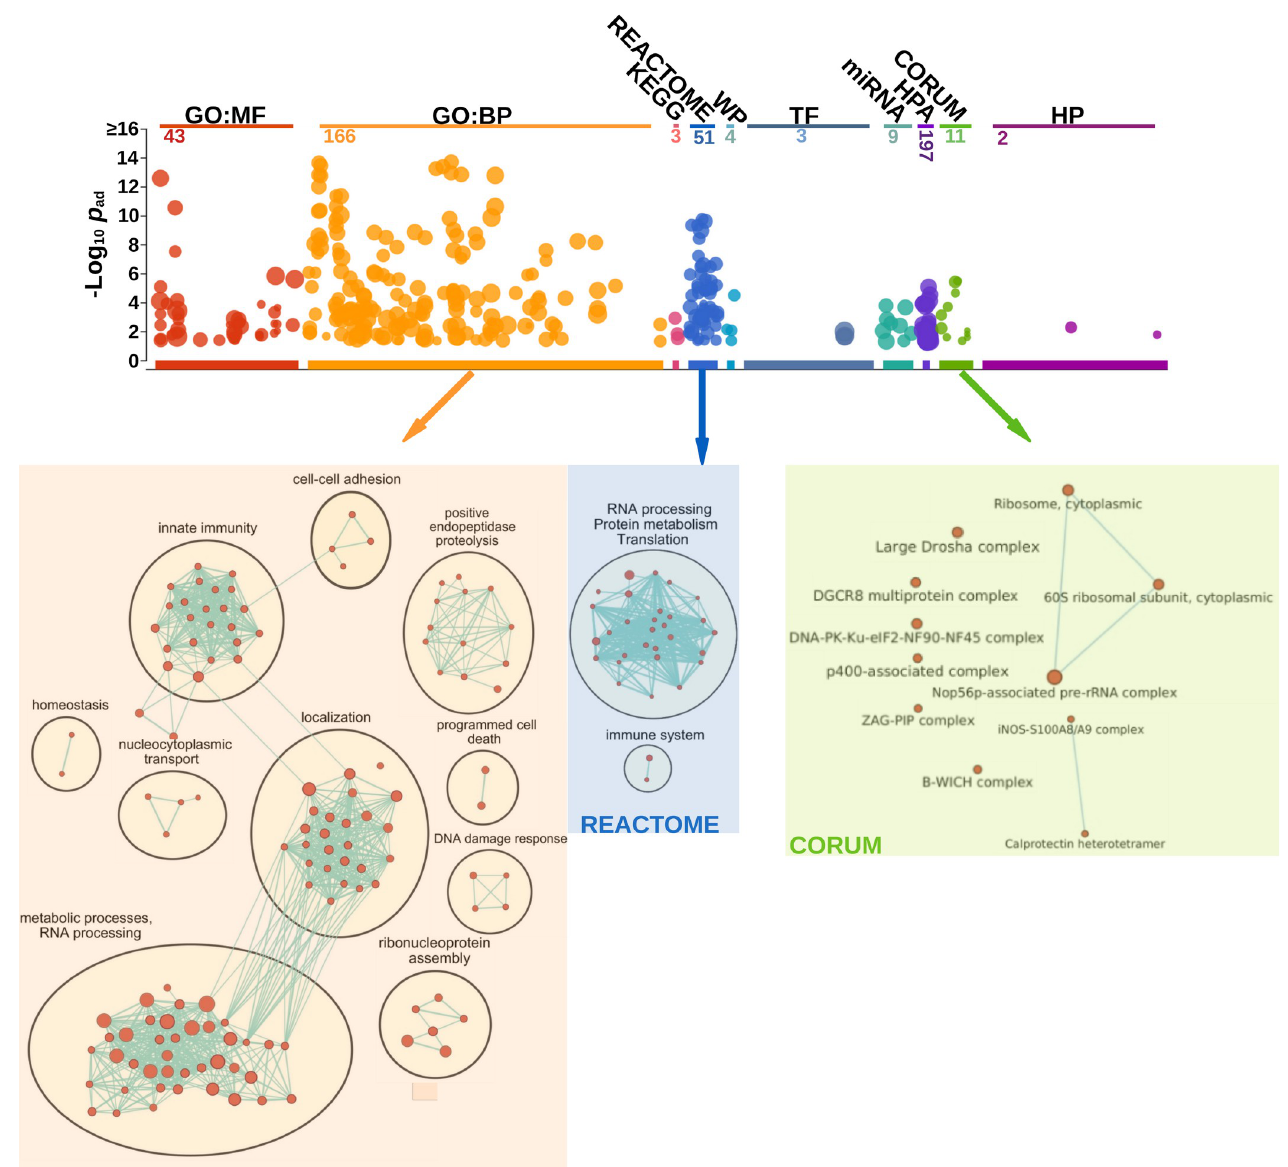
Fig 4. Bioinformatic analysis of biological processes of DEK/NUP214 interactors in g:Profiler and Cytoscape. g:Profiler–Shown are the numbers of the statistically relevant (p � 0.05) processes in the different resources of g:Profiler (GO: MF, GO: BP, KEGG, REACTOME, WP, TF, miR, HPA, CORUM, and HP). Here we show the refinement of the g:Profiler output from GO: BP, REACTOME, and CORUM by Cytoscape/EnrichmentMAP. As evidenced by connecting lines, the edge cut-off for protein overlap between processes was set at 0.7 for GO: BP and 0.5 for CORUM and REACTOME. All sets had a p � 0.05.